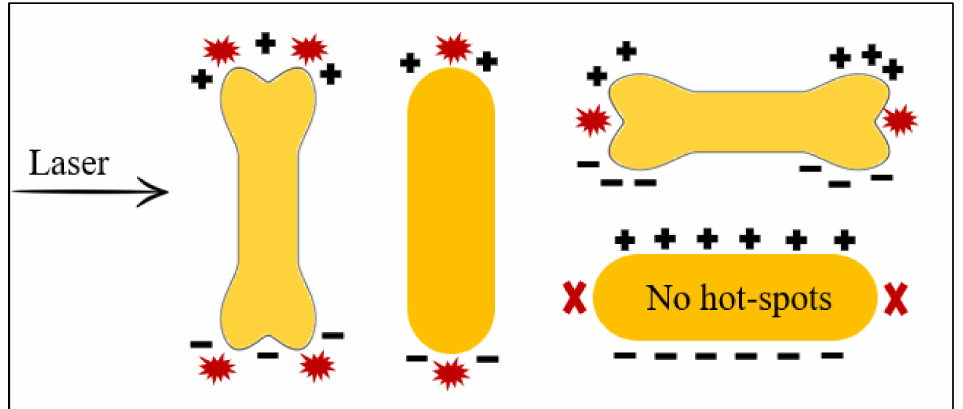
Figure 8. Schematic diagram of surface charge distribution in GNBs and GNRs, oriented parallel or perpendicular to the electric field. Adapted from [13].